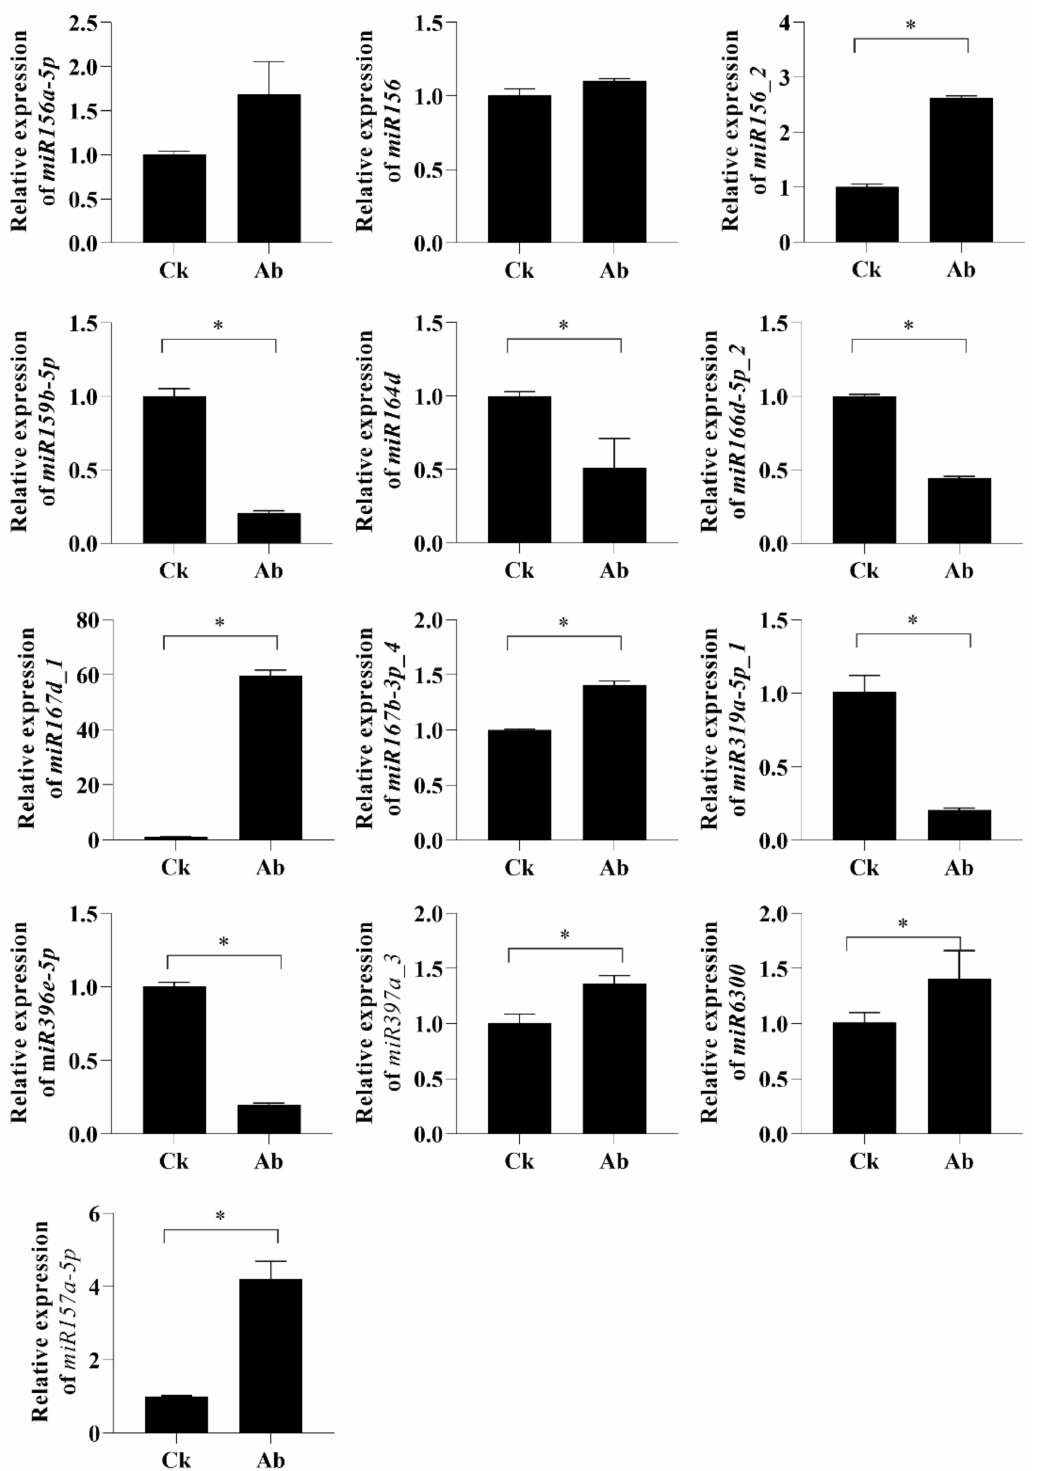
Figure 3. Relative expression level of 13 known miRNAs by RT-qPCR analysis. Normal (Ck) and aborting lotus flower buds (Ab) (2–3 cm in length) were collected for RT-qPCR analysis. Values are the means ± SE of three independent experiments with at least three replicates for each. U6 small nuclear RNA was used as an endogenous control to normalize the expression levels of miRNAs from RT-qPCR. Asterisks indicate that mean values are significantly different in comparison with Ck treatment at p < 0.05 according to a t -test. Ck, normal flower bud. Ab, aborting flower